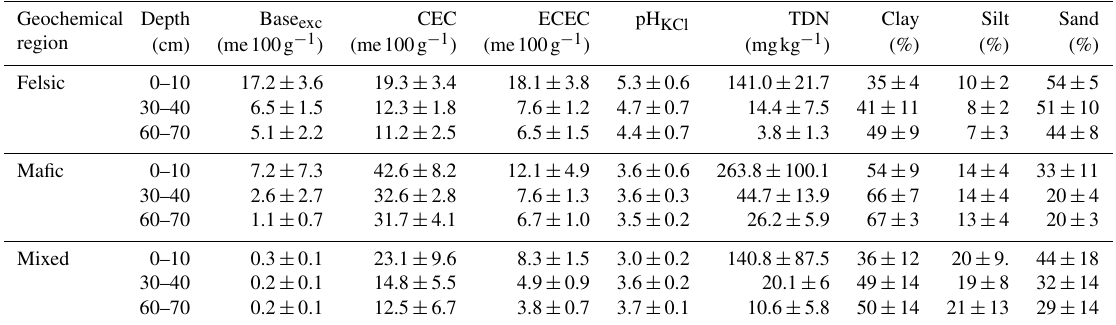
Table B2. Overview of soil properties and fertility indicators for the three geochemical regions and depth intervals. Base exc is the sum of exchangeable bases, CEC is potential cation exchange capacity and ECEC is effective cation exchange capacity. pH KCl is the soil pH mea- sured with potassium chloride, and bio-P is bioavailable phosphorus (Bray P method). Values reported are averages plus standard